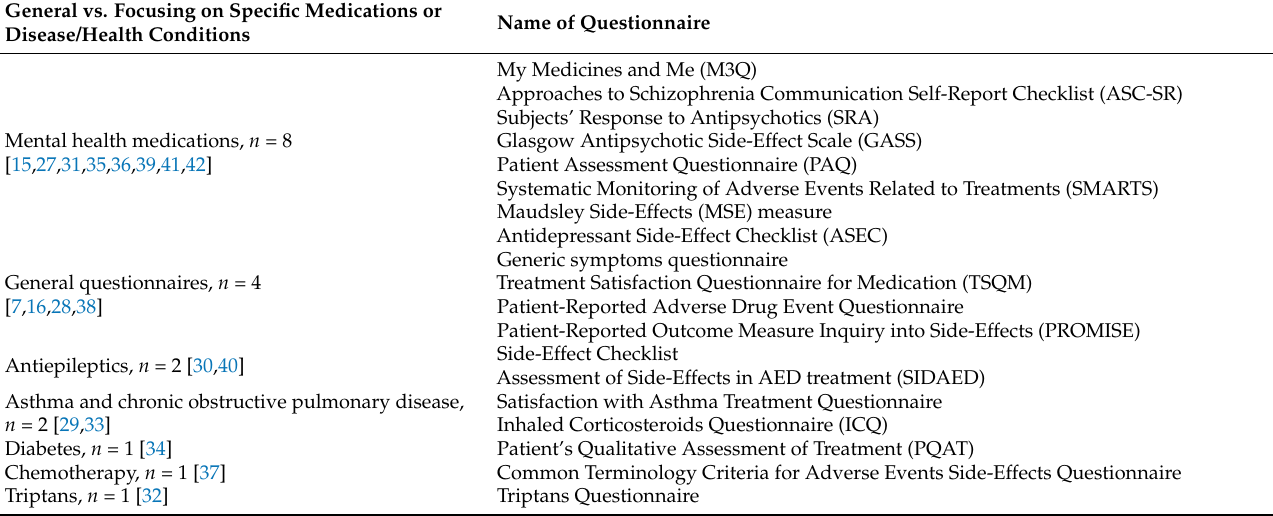
Table 1. List of questionnaires included in this systematic review.